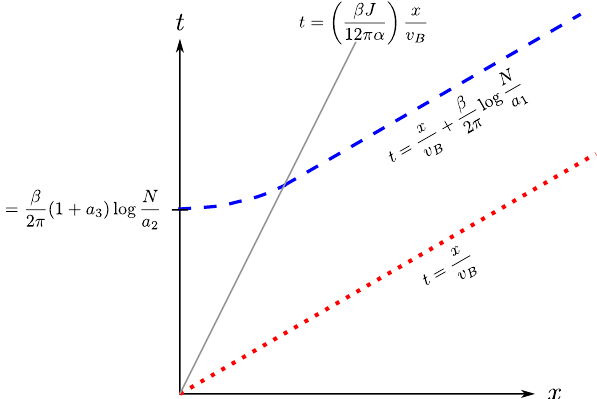
Figure 8. We sketch two level sets of the function F ( x; t ). The red/dotted line corresponds to F = 1 (cid:0) 1 , and the blue/dashed line corresponds to F = 1 . The blue/dashed curve is the butter(cid:13)y N 2 cone: operators above this location have large anticommutators with the operator at the origin. The gray solid line marks the transition between the behavior (5.9) to the right, and (5.10) to the left.